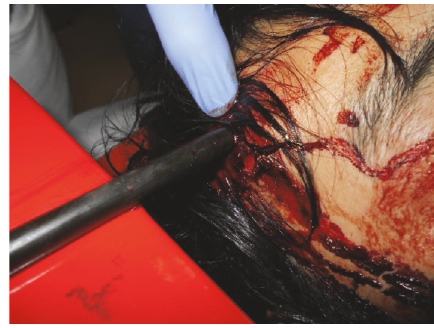
Figure 1: Photograph of a metal bar that had penetrated the right parietal region.